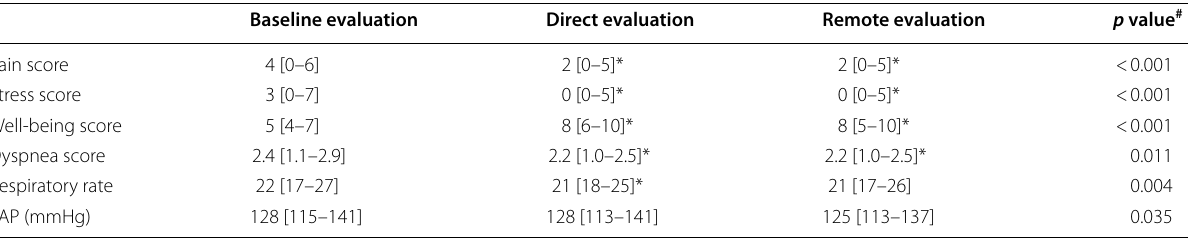
Table 1 Effect of corporeal rehabilitation care on psychological and functional variables